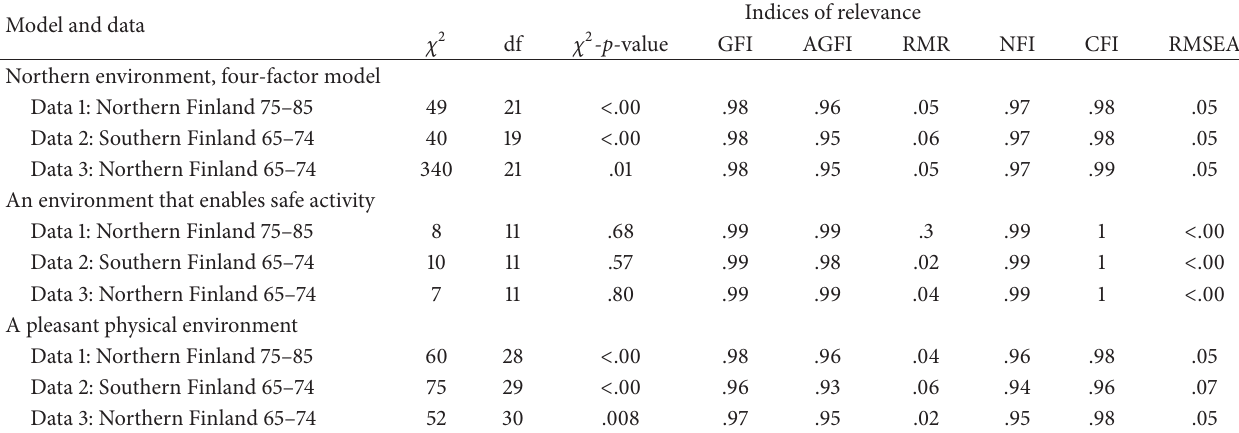
Table 2: The results of confirmatory factor analysis (data 1–data 3) as indices of relevance to the data. Model and